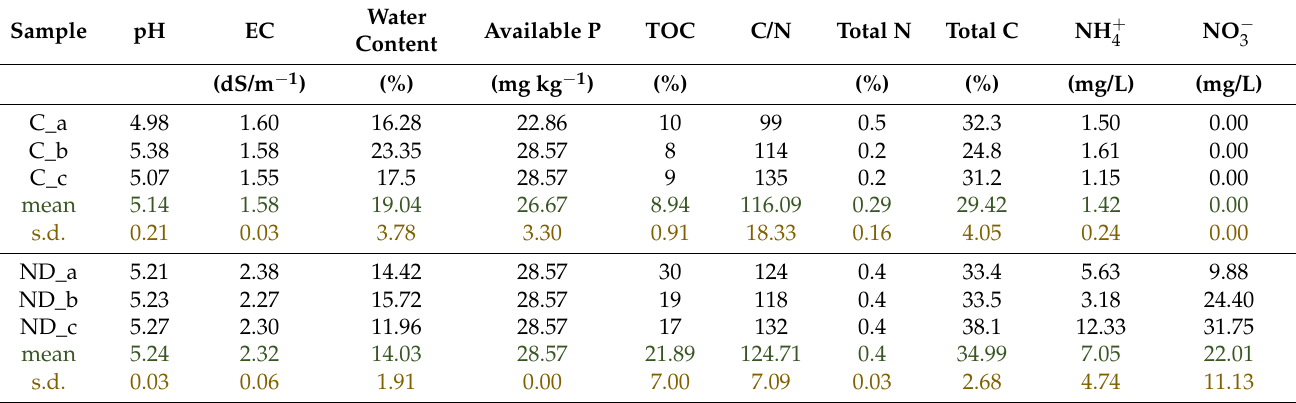
Table 1. Effect of biochar on soil chemical properties at the end of the cauliflower growing